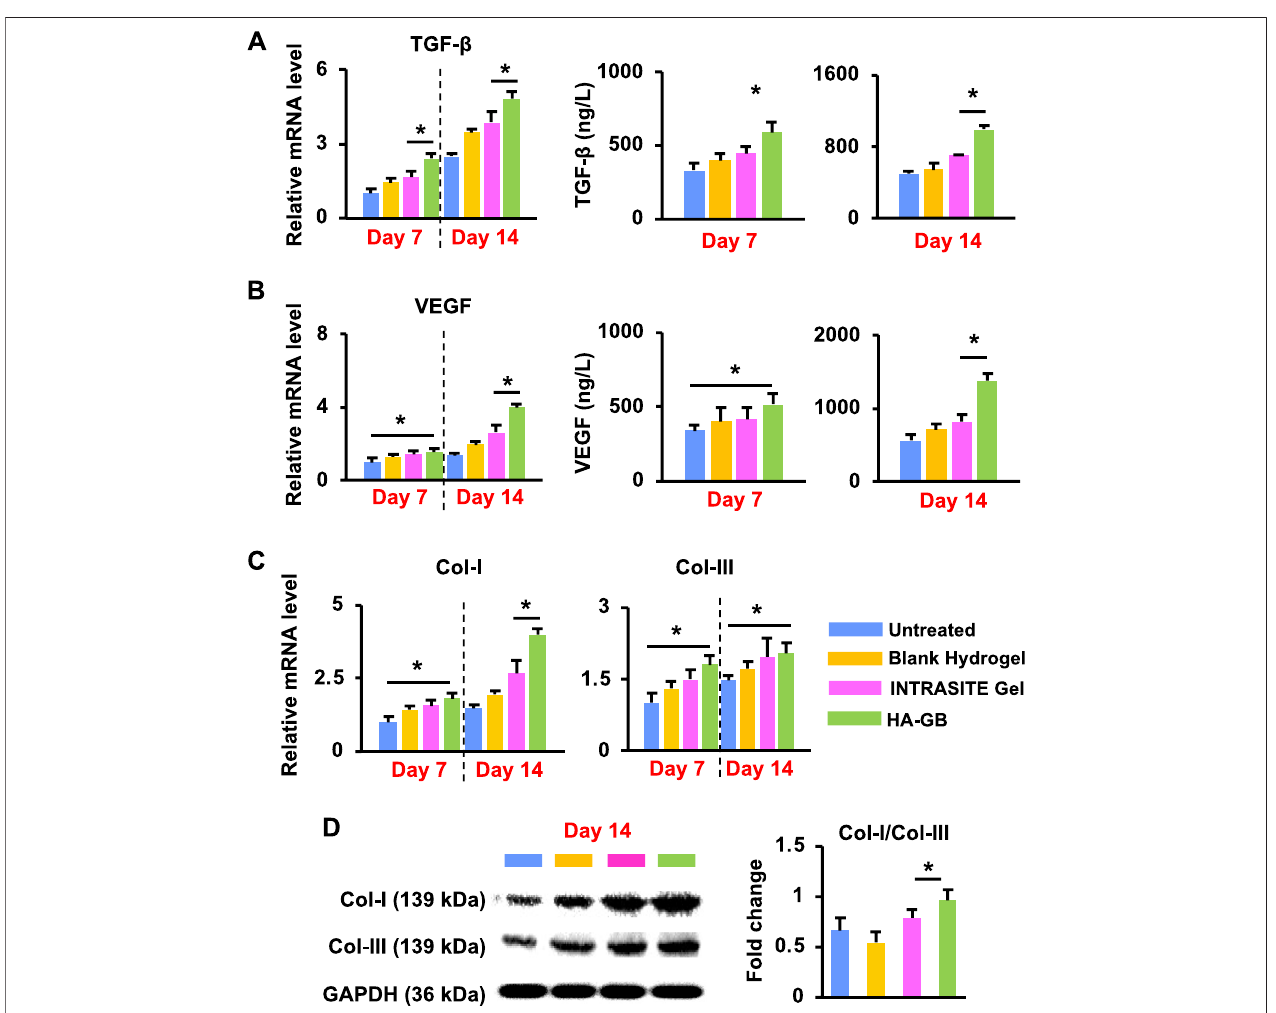
FIGURE7| Invivo pro-healingeffectsofHA-GB. (A) ThemRNAandproteinlevelsofTGF- β indiabeticwoundsfollowingHA-GBtreatment(1,000 μ mol/L)atDay7 and14( n =4;* p < 0.05). (B) ThemRNAandproteinlevelsofVEGFindiabeticwoundsfollowingHA-GBtreatmentatDay7and14( n =4;* p < 0.05). (C) ThemRNAlevel of Col-I and Col-III in diabetic wounds following HA-GB treatment ( n = 4; * p < 0.05). (D) The protein expression of Col-I and Col-III in diabetic wounds following HA-GB treatment ( n = 3; * p < 0.05).